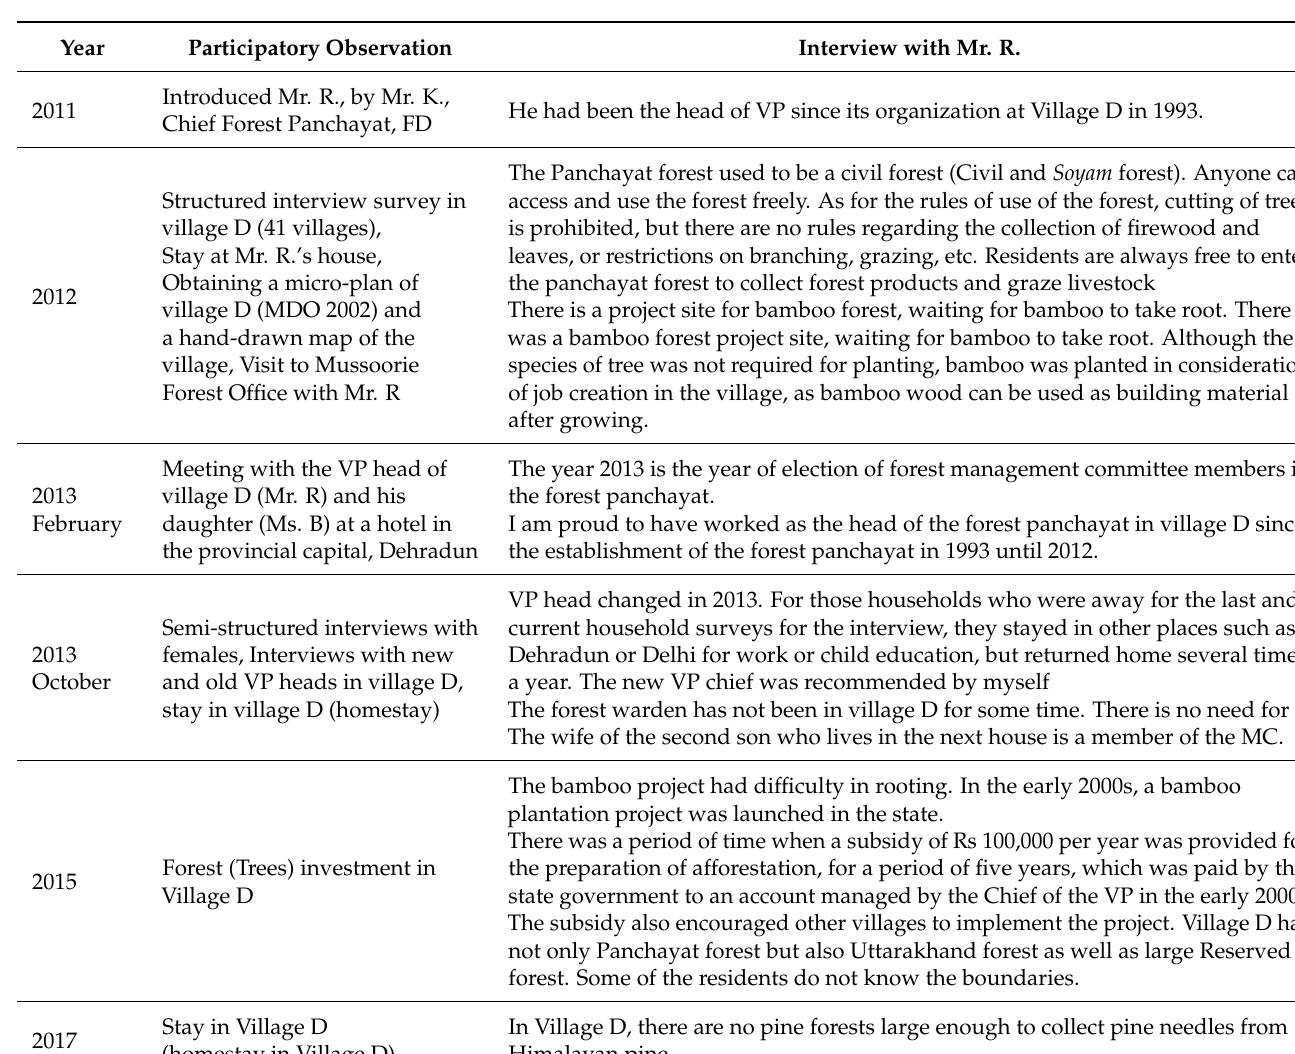
Table 7. Results of main interviews with the Van Panchayat chief and participant